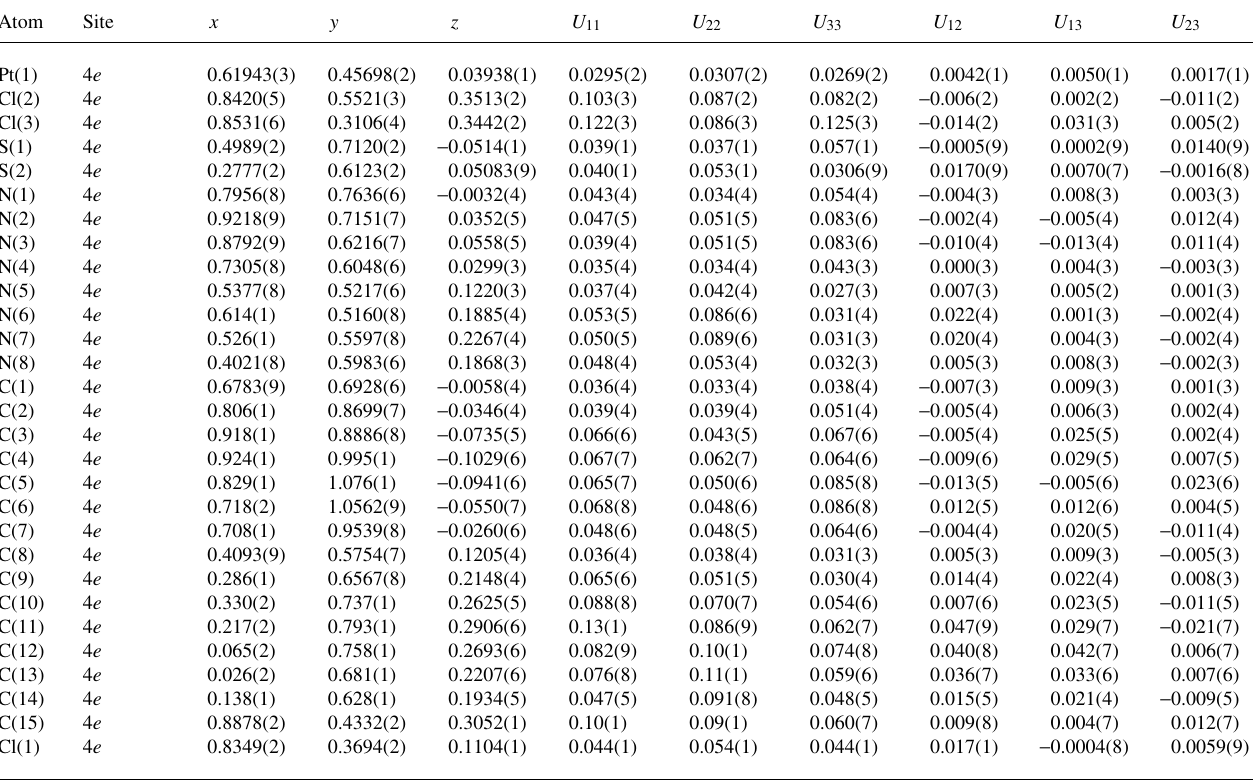
Table 3. Atomic coordinates and displacement parameters (in Å 2 )